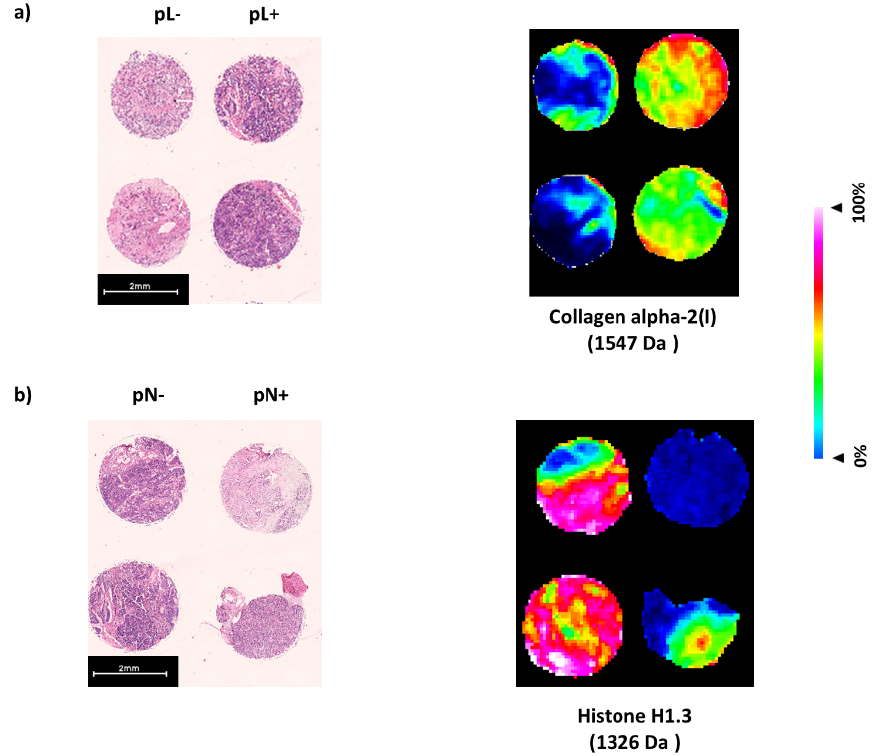
Figure 3. Differential spatial distribution and intensity of the subgroups with and without the respective prognostic histopathological feature ( a ) lymphatic vessel invasion, pL, ( b ) nodal metastasis, pN) for corresponding proteins. Peptide (1541 Da) from Collagen alpha-2(I) shows increased intensity distribution in patients with lymphatic vessel invasion (pL+) whereas peptide (1326 Da) from Histone H1.3 shows decreased intensity distribution in patients with nodal metastasis (pN+). For orientation hematoxylin and eosin stained tissue sections are show on the left.